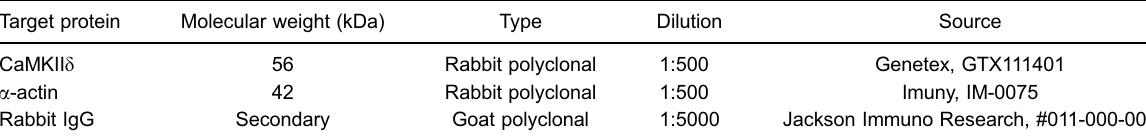
Table 2 . List of